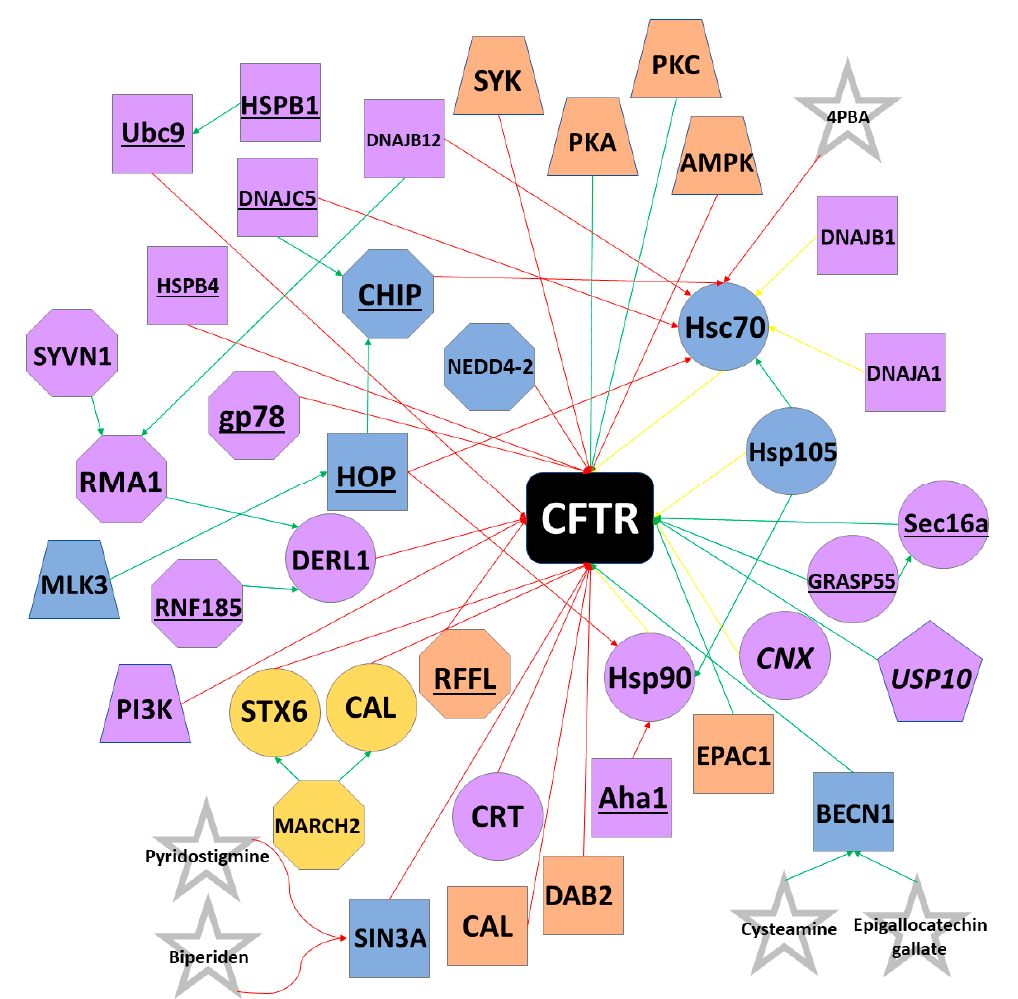
Figure 4. CFTR Proteostasis Interactors. Selected proteins active in the CFTR proteostasis pathway are shown. Octagons represent E3 ubiquitin ligases; trapezoids indicate kinases; circles represent chaperones; pentagons indicate deubiquitinases; co-chaperones and all other proteins are represented as squares; proteostasis modulators are represented as stars. Red arrows indicate degradation interactions; green arrows represent activation or maturation interactions; yellow arrows indicate that the protein can have degradative or activation interactions. In most cases, these proteins degrade Phe508del, while promoting wtCFTR maturation. Proteins shaded in purple primarily interact with co-factors or CFTR at the ER; orange at the cell surface; yellow at the Golgi apparatus. Proteins shaded in blue can interact with co-factors or CFTR at the ER or cell surface. Underlined proteins are primarily only found in the Phe508del proteostasis pathway, whereas italicized proteins are usually found in the wtCFTR pathway. Curved lines indicate that pyridostigmine and biperiden are believed to act by mimicking the transcriptional changes resulting from downregulation of SIN3A. Please note that the most common interactions and locations for each protein are shown. Some proteins are active at multiple locations.